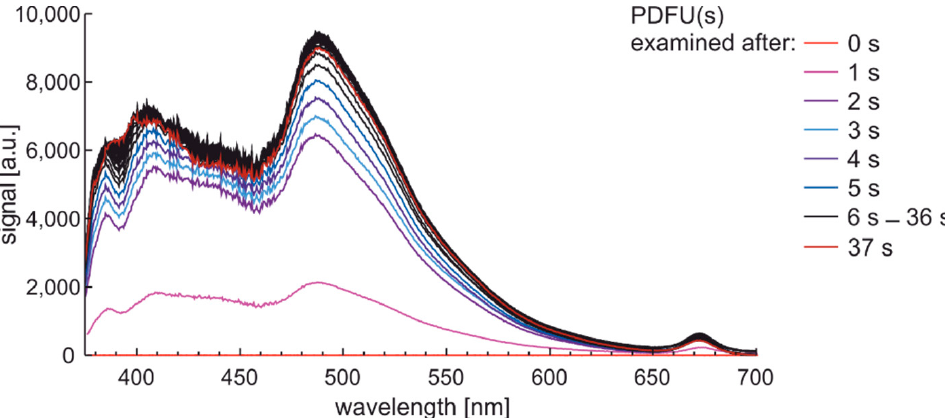
Figure 13. Fluorescence spectra of premium diesel fuel of unmodified and summer type while examined with a 1-s sequence of sampling.